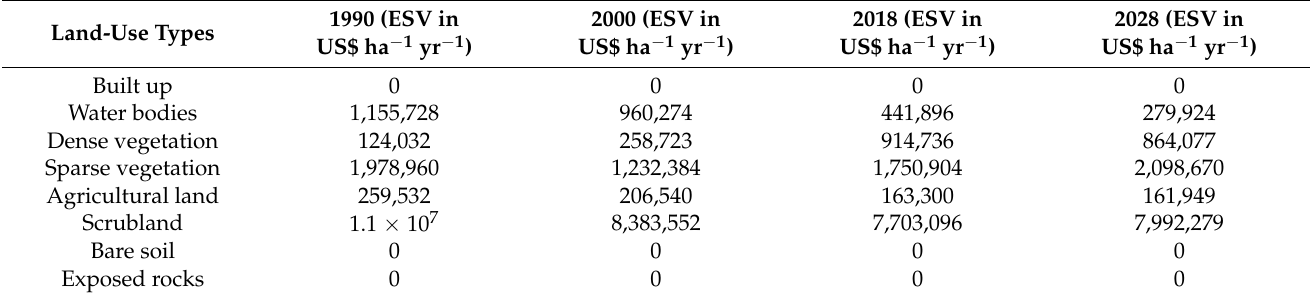
Table 3. Estimated ESV of different LULC types for 1990, 2000, 2018, and